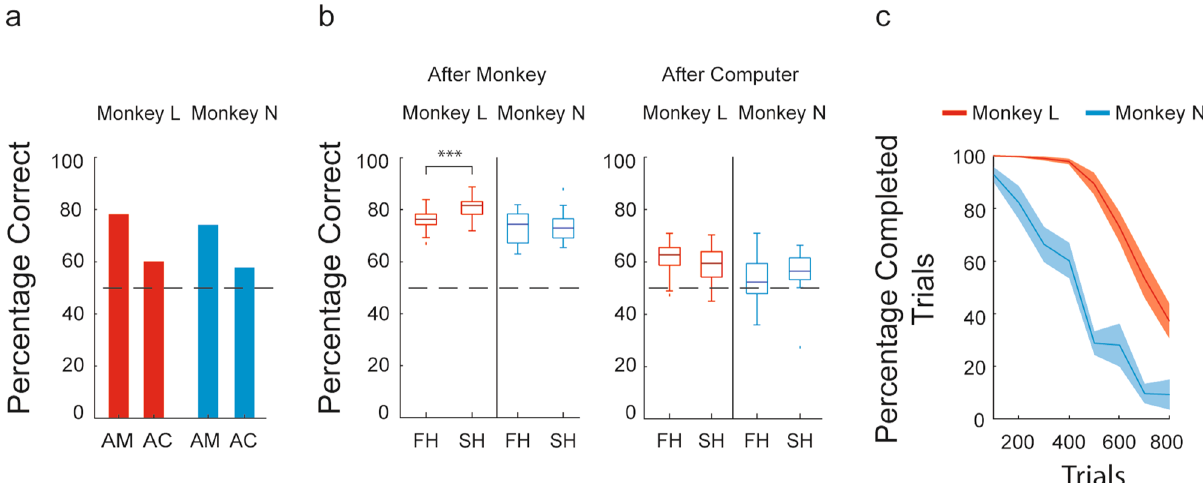
Figure 3. Behavioral results of experiment 2. ( a ) Overall performance. Bars represent the percentage of correct choices in after-monkey and after-computer trials, based on all the sessions in experiment 2 (29 and 21 sessions for monkeys L and N, respectively). ( b ) Stability of the monkeys’ performance within sessions in after-monkey and after-computer trials. The structure of the boxplots and calculation of the percentages of correct choices are as described in Fig. 2e, except they apply to the after-monkey and after-computer trial categories. In both graphs, the dashed line indicates 50%, the level associated with responses dictated by chance alone. Asterisks indicate significant differences (***p < 0.001, Wilcoxon signed-rank test). ( c ) Stability of the monkeys’ interaction with the apparatus. The curves represent the mean percentage of completed trials (see experimental procedures) calculated in moving windows of 100 trials, using the sessions presented in ( a